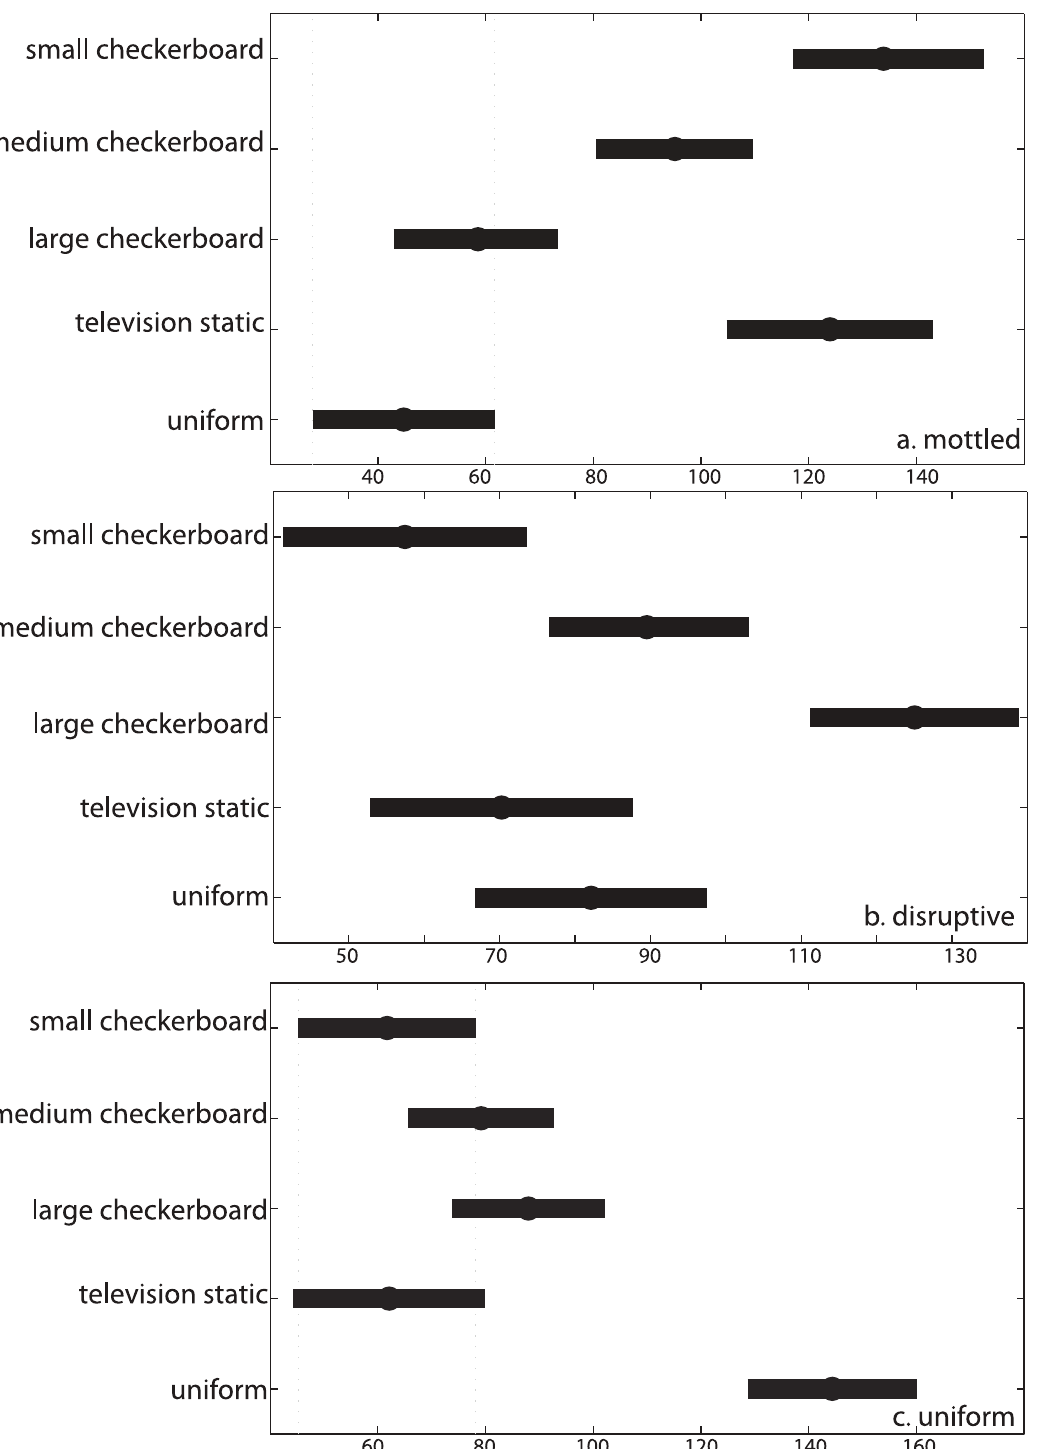
Fig 8. Comparison of individual components of camouflage response to bottom stimulus patterns. (a) percent mottled, (b) percent disruptive, and (c) percent uniform. The dots represent means and bars represent standard deviations. An overlap of the lines in each panel indicates that the groups were not significantly different based on a post-hoc test using the Dunn-Sidak